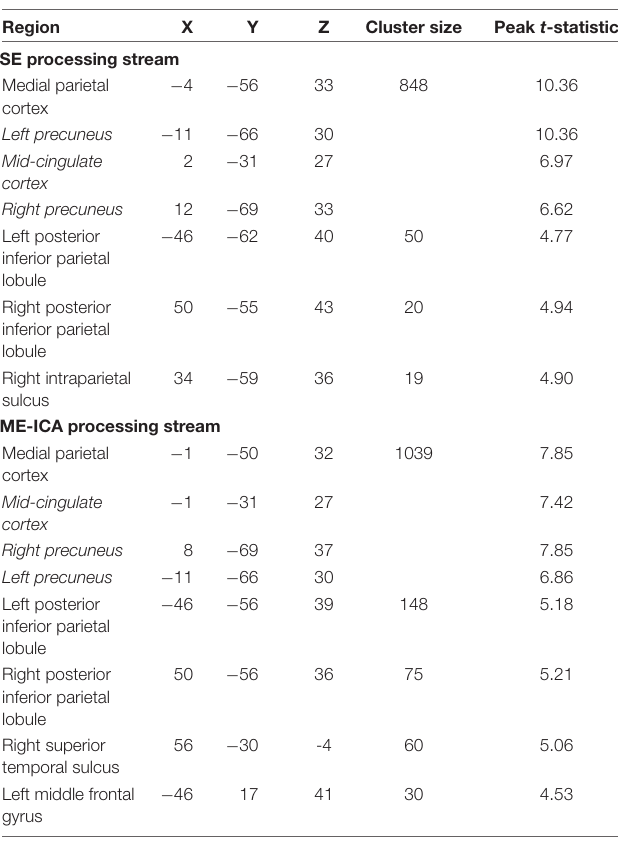
TABLE 2 | Regions identified in the voxelwise analysis of temporal distance effects for SE and multi-echo-ICA processing